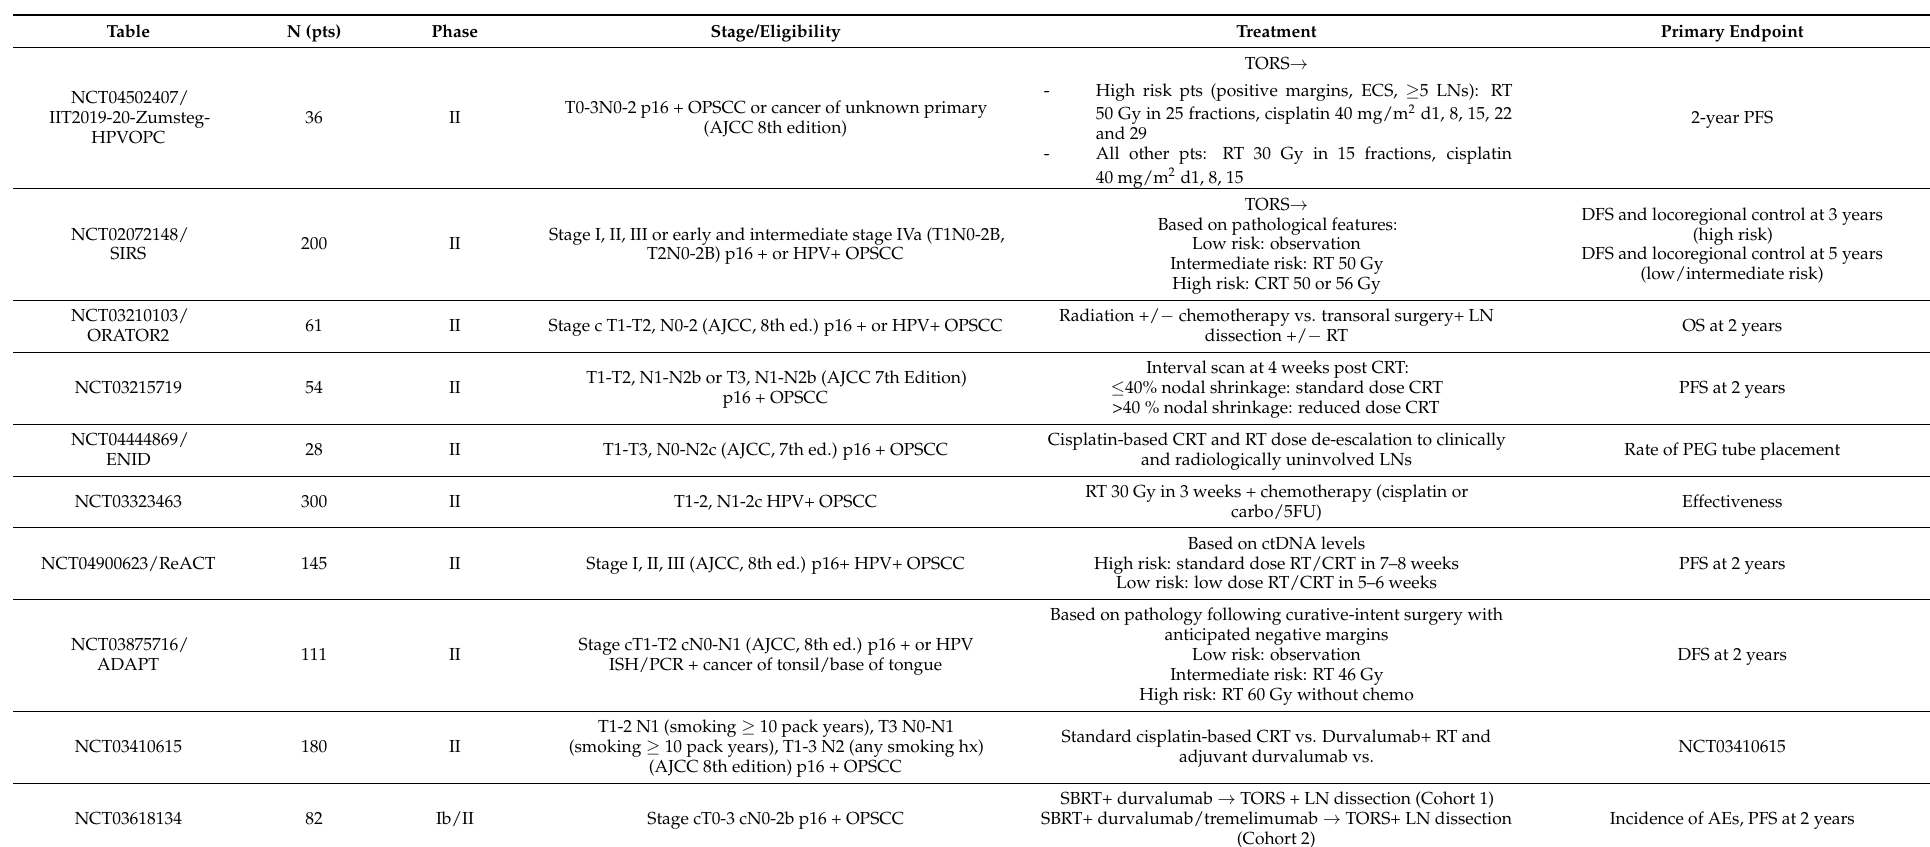
Table 1. Ongoing clinical trials of treatment deintensification in HPV+ OPSCC.